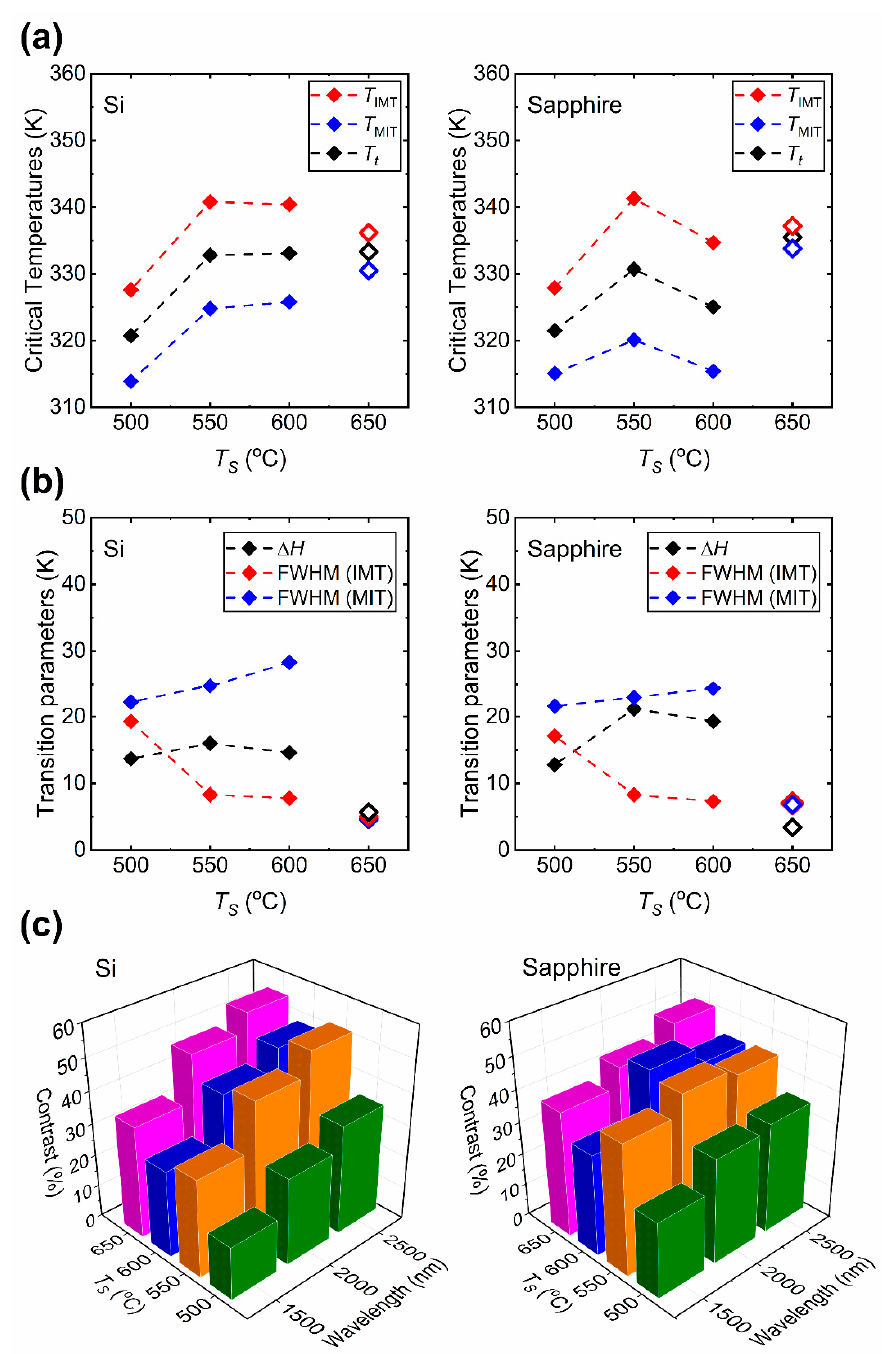
Figure 8. ( a ) Critical temperatures ( T IMT , T MIT and T t ) of the VO 2 films on Si and sapphire prepared at various substrate temperatures ( T S ) obtained at a light wavelength of λ = 2500 nm. ( b ) Hysteresis ( ∆ H ) and sharpness (FWHM) of the Gaussian curves obtained from d (cid:101) T /d T vs. T plots in Figure 7. In ( a ) and ( b ) the data points for films prepared at 650 ◦ C [17] are shown in hollow symbols. ( c ) Comparison of optical transmittance contrast, ∆ (cid:101) T = (cid:101) T ( 300 K ) − (cid:101) T ( 368 K ) , obtained at NIR wavelengths λ = 1500 nm, 2000 nm and 2500 nm for films prepared at T S = 500 (olive), 550 (orange), 600 (navy) and 650 [17] (magenta) ◦ C. (cid:101) T lum is obtained for a wavelength range between 380 and 780 nm and (cid:101) T sol is obtained for wavelengths between 300 and 2500 nm. ϕ lum ( λ ) is the spectral sensitivity of the light adapted human eye [51], ϕ sol ( λ ) is the solar irradiance spectrum for air mass of 1.5 (37